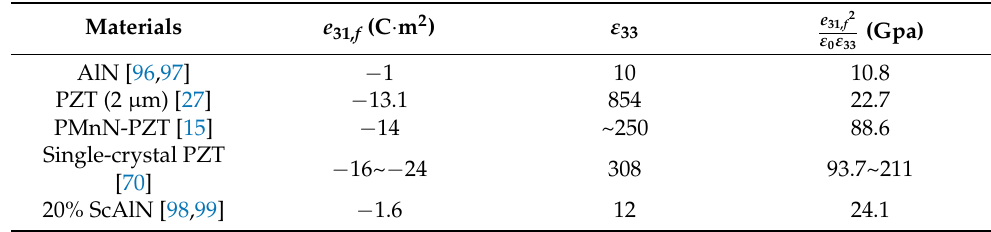
Table 5. Comparison of piezoelectric materials for pMUT rangefinders. Reproduced with permission from [70], Copyright 2021,